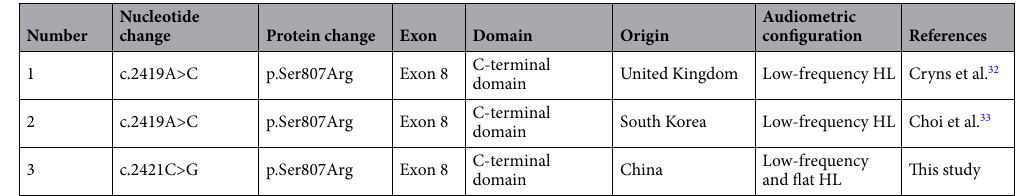
Table 3. Overview of all WFS1 p.Ser807Arg mutations identified to date.